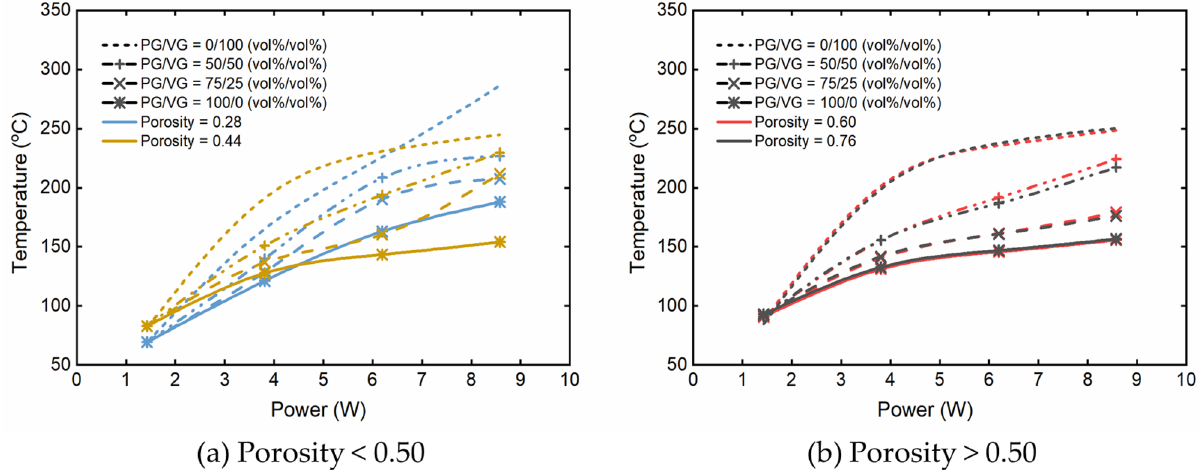
Figure 2. Model predictions of liquid temperature based on the input power for different liquids (PG/ VG = 0/100, 50/50, 75/25, 100/0 vol%/vol%) at ( a ) porosity < 0.50 (0.28, 0.44) and ( b ) porosity > 0.50 (0.60, 0.76) with 3 s puff duration, 30 s puff interval and 55 mL puff volume.